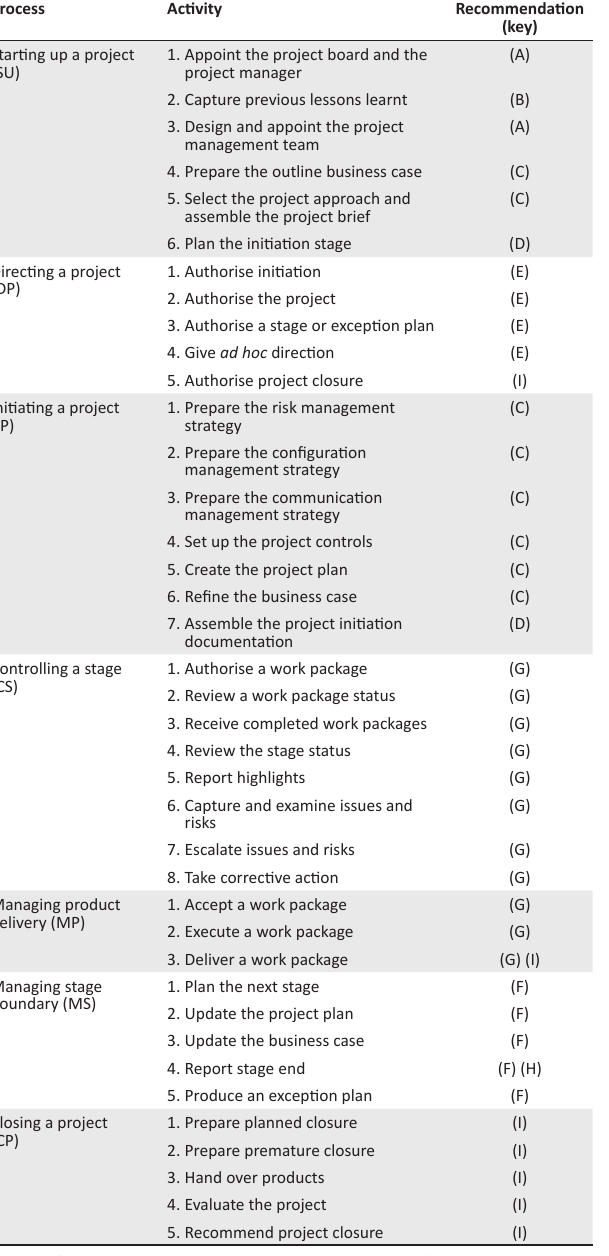
TABLE 2: Recommendations for small- and medium-sized entities considering using Projects in Controlled Environments. Process